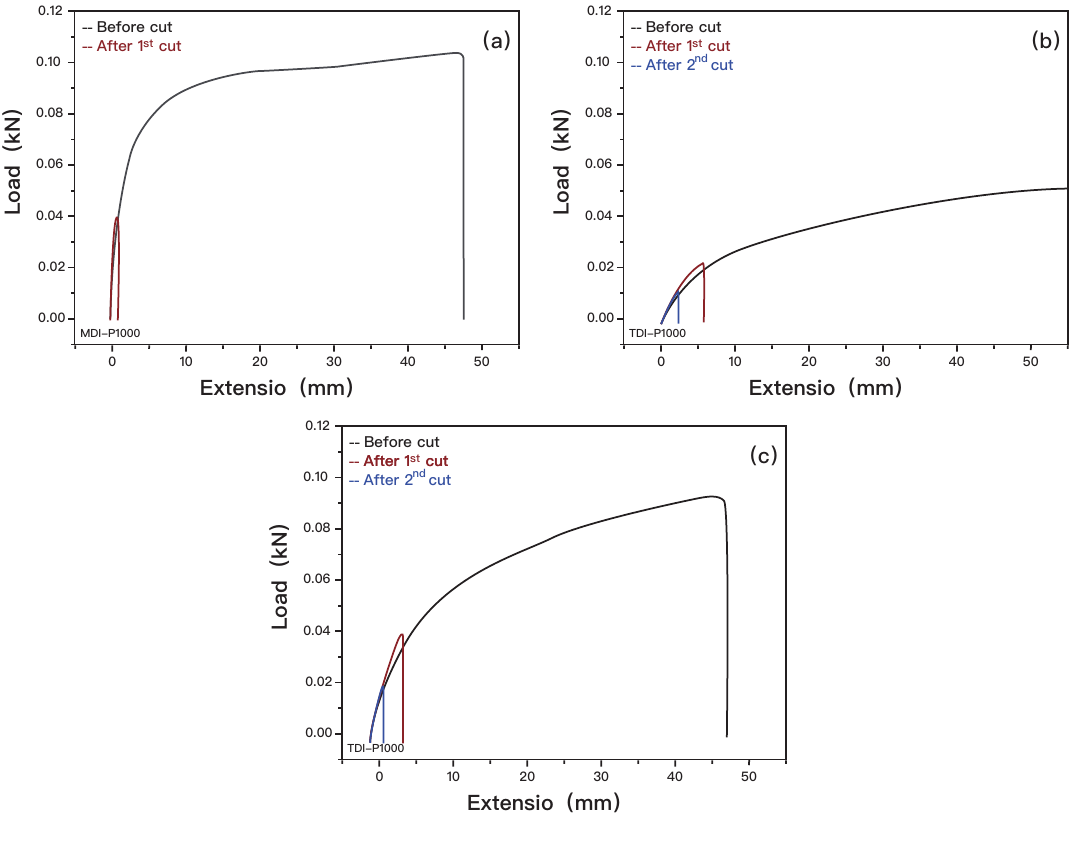
Figure 7. Graph of load vs. extension for before and after cut of ( a ) MDI-P1000, ( b ) TDI-P1000, and ( c )